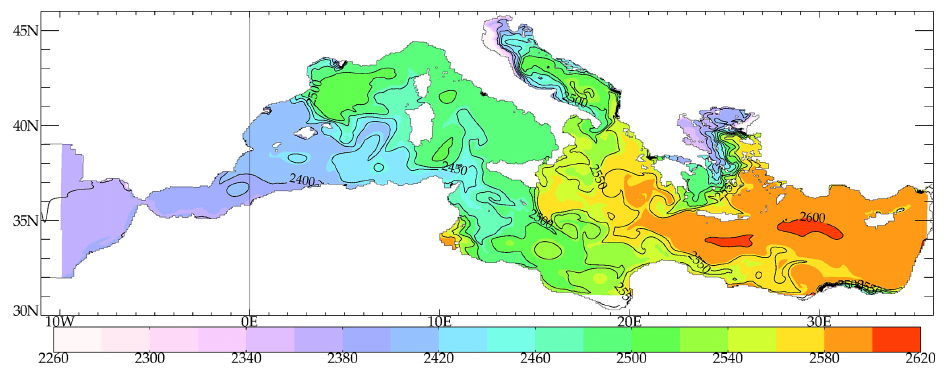
Figure 3. Salinity-derived surface total alkalinity field (µmolkg − 1 ) calculated with the formula of Schneider et al. (2007) (Eq. 11) applied to the model’s surface salinity field from November 2001. Table 1. Coefficients a i , b i , and c i (where the index i varies from 0 to 9) used to compute z 1 , z 2 , and z 3 with Eq. (13). i a i b i c i